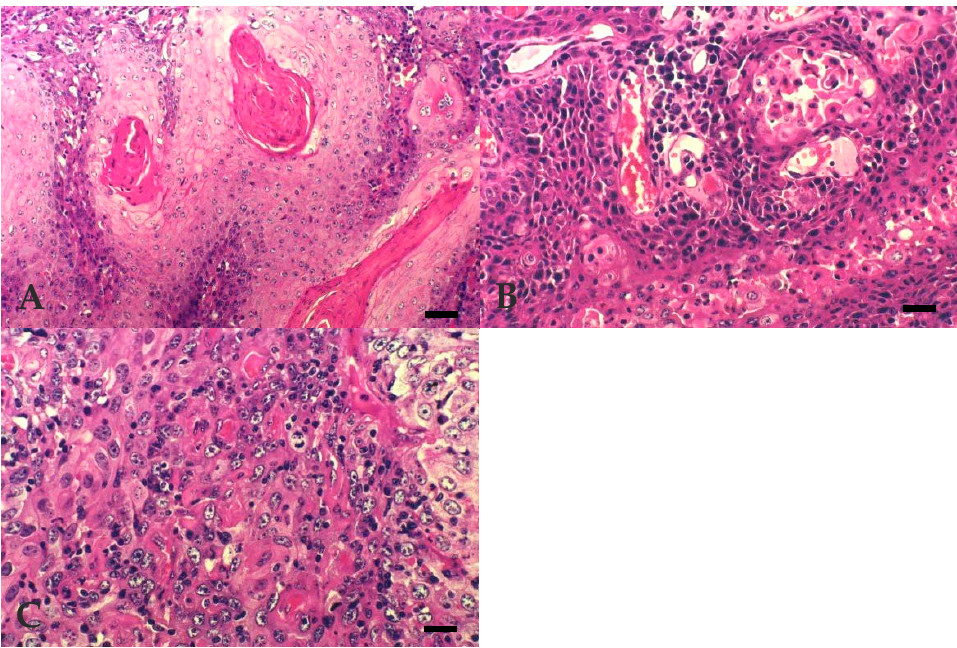
Figure 1. Bovine Ocular Squamous Cell Carcinoma. ( A ) WD: extensive keratin pearl formation. Bar, 50 μ m. ( B ) MD: acantolytic cysts. Bar, 25 μ m. ( C ) PD: individual cell keratinisation with more pleomorphic and atypical cells. Bar, 25 μ m. Hematoxylin Eosin (HE). Dysqueratotic and acantolytic cells were present in the three degrees of differentiation.